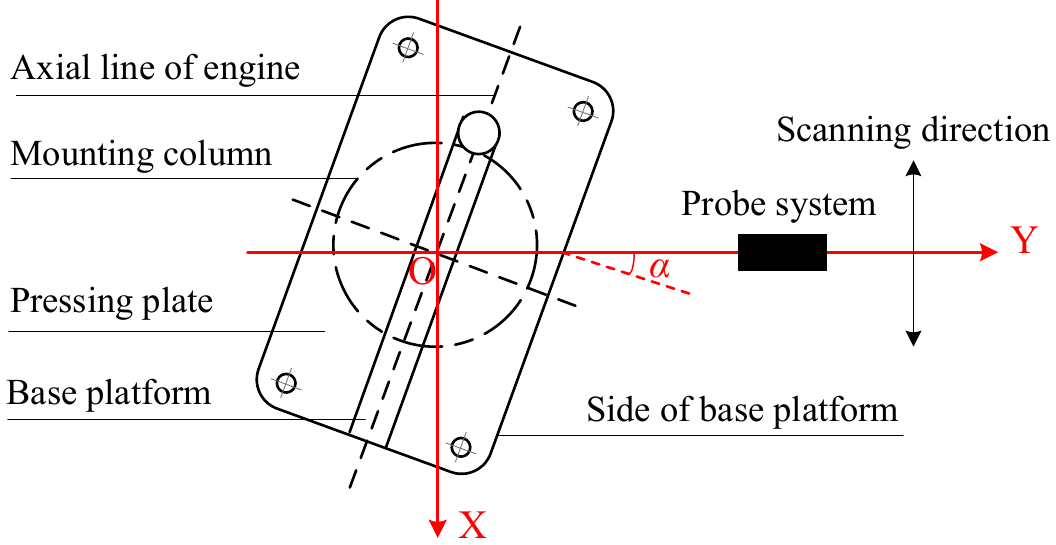
Figure 6. Registration diagram of aeroengine axis.